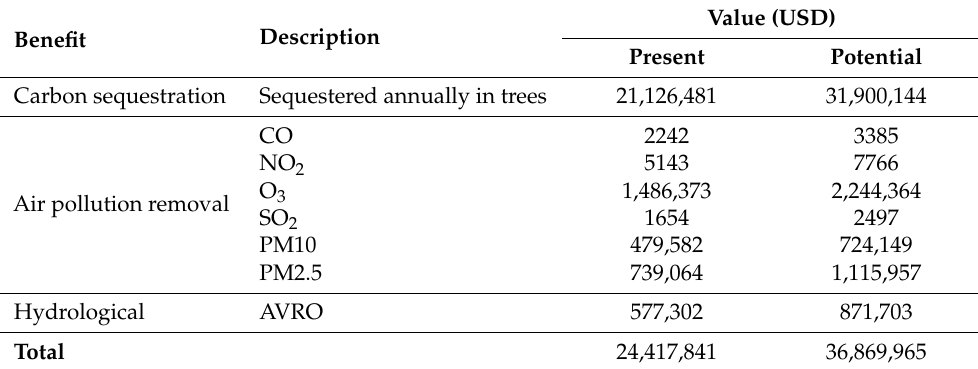
Table 5. Hydrological benefits from tree coverage in Megalitres (Ml).